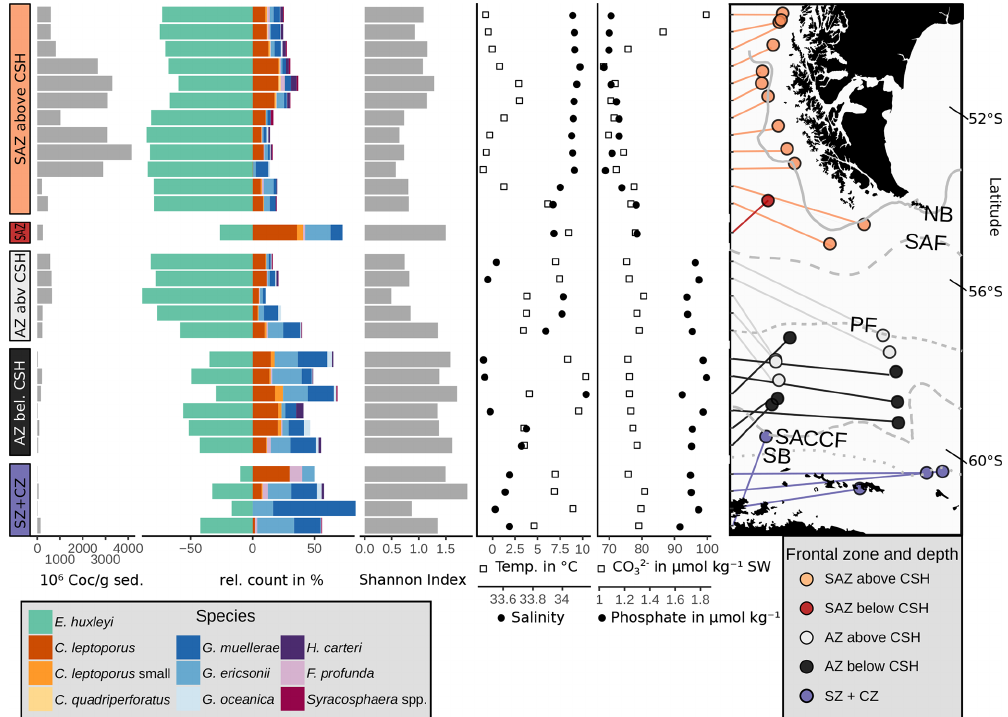
Figure 8. Absolute coccolith abundance, relative abundances of the main species, Shannon diversity index (see Sect. 3) and environmental parameters at sample depth (CO 2 − ) and at 10m water depth (phosphate, salinity and temperature) from north to south related to frontal zone 3 and water depth. Sources of environmental variables as indicated in Sect. 3.3. CO 2 − and phosphate in µmolkg − 1 seawater (SW). Note that 3 the map is tilted (lines of latitude for reference). ACC fronts from north to south: NB (Northern Boundary), SAF (Subantarctic Front), PF (Polar Front), SACCF (Southern ACC Front) and SB (Southern